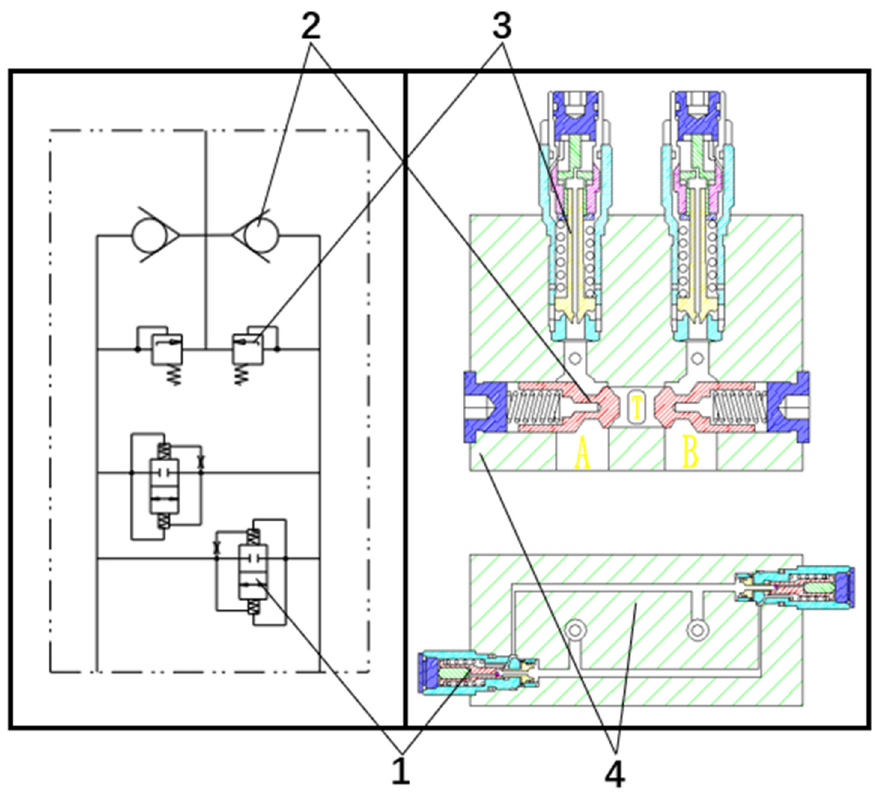
Figure 8. The structure and principle of cushion valve: 1-anti-vibration valve; 2-one-way valve; 3- secondary relief valve; 4-valve body.